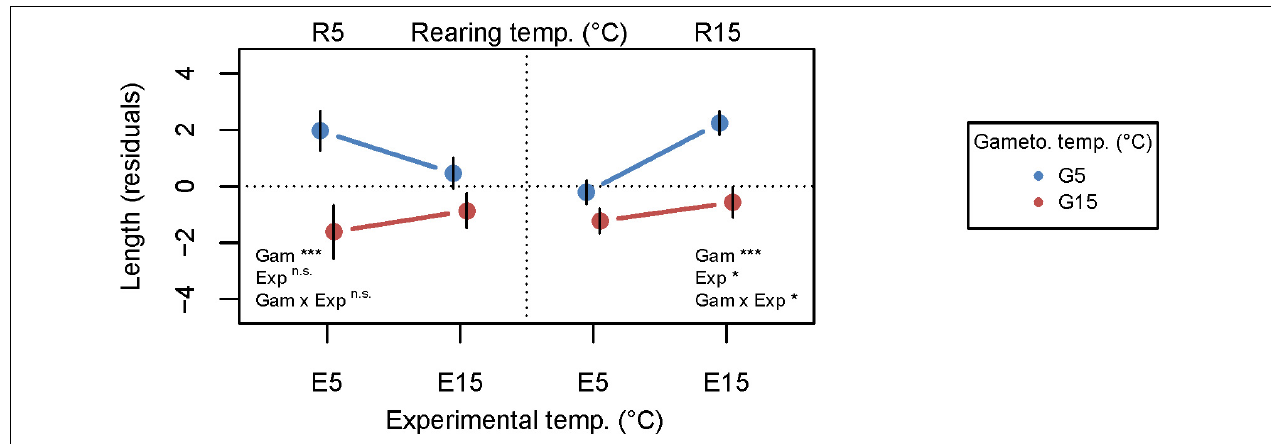
FIGURE 3 | Growth reaction norms of juvenile Laminaria digitata sporophytes in experiment 2 to visualize effects of gametogenesis temperature on thermal plasticity of sporophytes. Primary x-axis: experimental temperature, secondary x-axis: rearing temperature, symbol colors: gametogenesis temperature. Residuals of simple linear models of final length as a function of initial length are shown as a growth parameter. The zero-line represents the final length modeled based on initial length, and deviations from the zero-line are interpreted as treatment effects. Mean over all genetic lines ± SE, n = 20. Statistical significance of the fixed factors gametogenesis temperature (Gam), experimental temperature (Exp) and their interaction (Gam × Exp) is summarized in the figure; *** p < 0.001; * p < 0.05; n.s., not significant. For full statistical report see Table 2 .